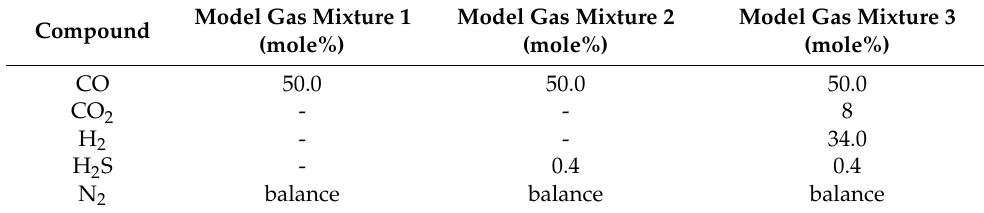
Table 1. Model gas mixtures used during the catalytic tests.